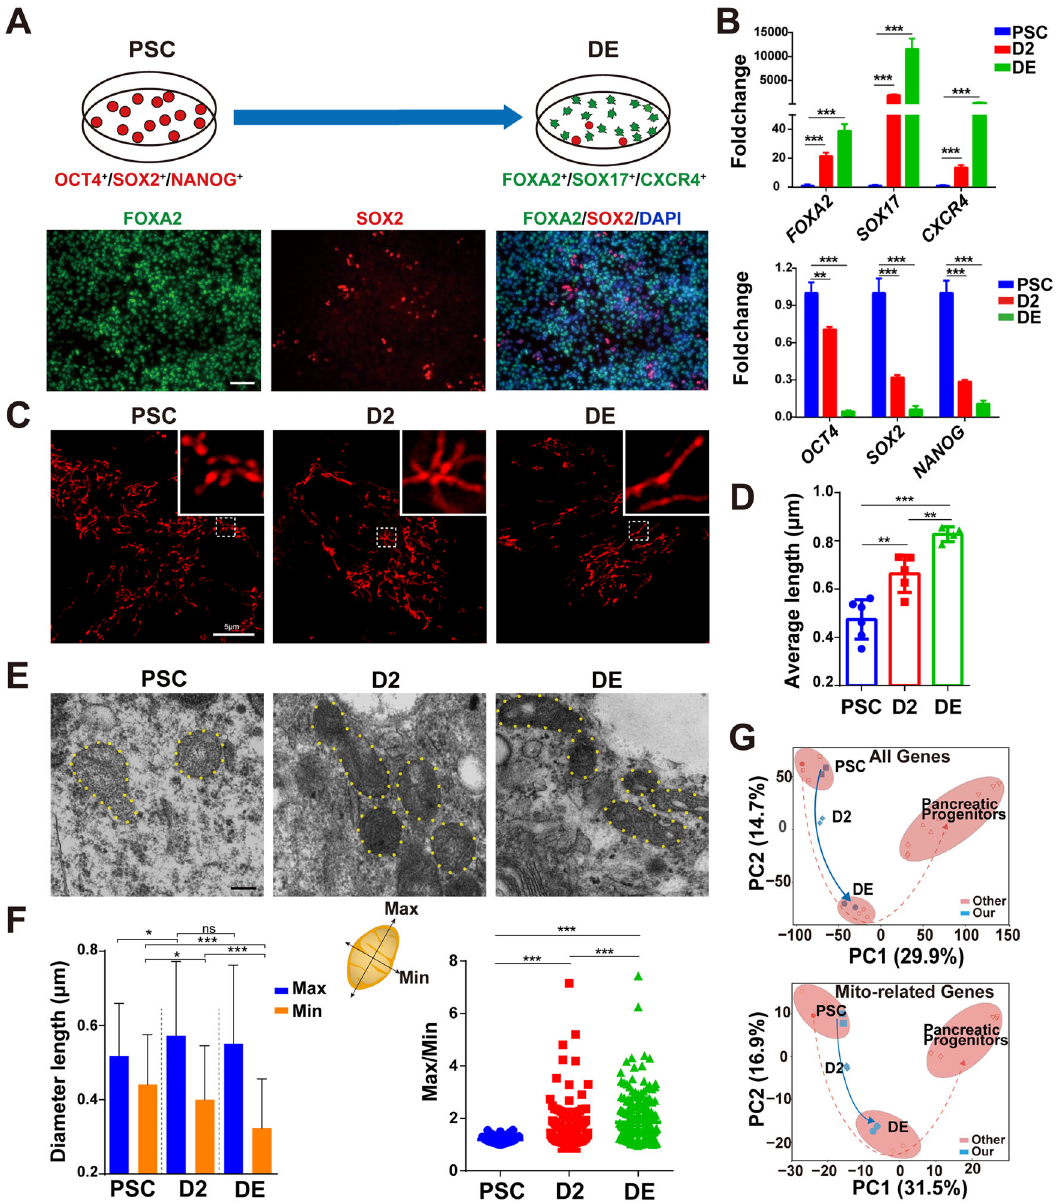
Fig. 1 Mitochondria are more mature during human DE differentiation. A Scheme of DE differentiation. FOXA2 + (green), SOX17 + , and CXCR4 + cells represented differentiated DE cells, and OCT4 + , SOX2 + (red), and NANOG + represented pluripotent cells (nucleus, DAPI, blue). Scale bar = 400 μ m. B RNA expression analysis of differentiation markers and pluripotency markers during DE differentiation. Data are normalized to the mRNA level of PSCs ( n = 3). C Representative images of MitoTracker staining observed through confocal in DE differentiation of iPSCs. Scale bar = 5 μ m. D Quantitative statistics of mitochondrial average length in ( C ) using the MINA tool. E Representative mitochondrial images of ESCs, D2, DE were observed through a transmission electron microscope. Scale bar = 2 μ m. F The ratio of Max/Min axes and diameter length of mitochondria ( E ) were statistically analyzed from about 20 independent images. G PCA analysis of all genes (top) and mitochondria-related genes (bottom) in pancreatic differentiation (GSE114099, red) and our DE differentiation (blue). All data are shown as mean ± SD. ns, not signi fi cant. * P < 0.05, ** P < 0.01 and *** P <